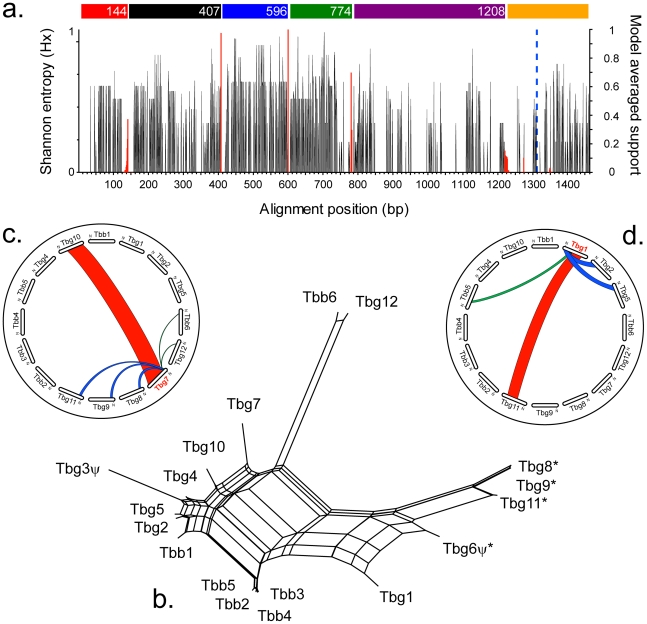
Analysis of sequence variation among T. brucei 65 kDa invariant surface glycoprotein genes.Gene copies are numbered consecutively in positional order from left to right on the chromosome, beginning with Tbb1 (Tb927.2.3270) and Tbg1 (Tbg972.2.1130) respectively. a. Sequence variation (expressed as Shannon entropy score, left scale) along a multiple sequence alignment, combined with recombination breakpoints (red lines, right scale) inferred by GARD analysis. A dotted blue line marks the boundary between coding and 3′ UTR regions. Coloured bars above the chart indicate recombination tracts as identified by GARD. b. A phylogenetic network including sequences unique to one subspecies (marked with an asterisk *). Annotated pseudogenes are indicated by ψ. c. A chart showing the affinities of sequence Tbg7 only; all sequences are represented in a circle, coloured bars connect Tbg7 (or regions thereof) to its closest relative among other sequences. Different colours are used to denote different affinities. d. Affinity chart for Tbg1.